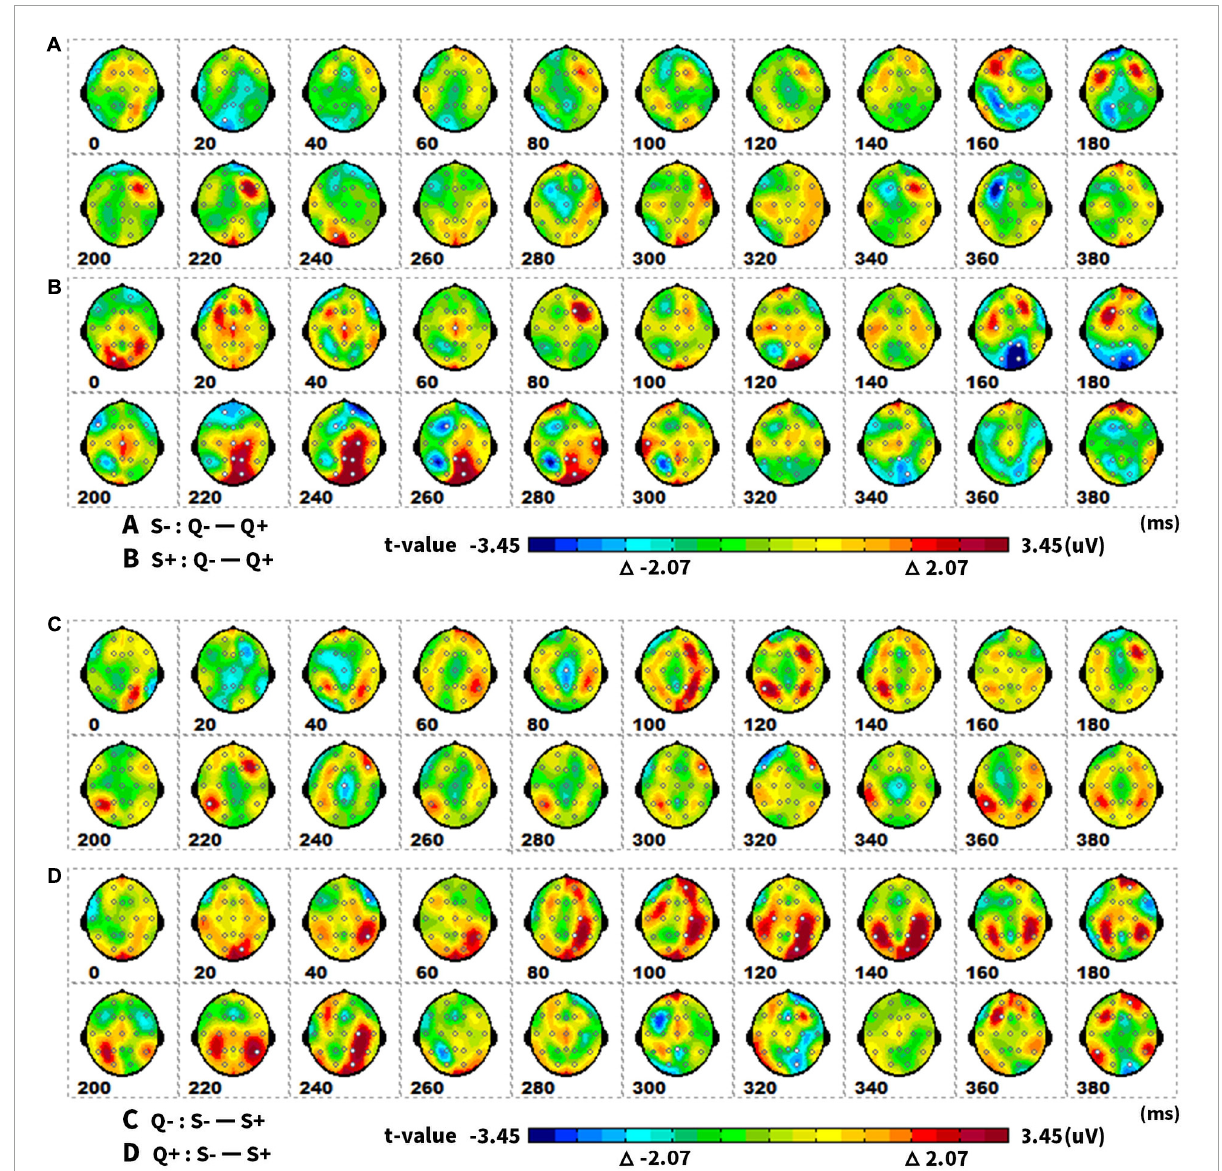
FIGURE7 The spatiotemporal patterns of SPM (t) (0 to 400 ms) are derived from the pairwise comparisons between the conditions (Q–, Q + , S–, S +): (A) (S–. Q– – Q +), (B) (S + . Q– – Q +), (C) (Q–. S– – S +), (D) (Q + . S– – S +). Each map was interpolated from the average t -values within the fixed 20-ms time window, and the red/bright blue bin of the color scale corresponded to the 0.05 significance threshold: t (1,23) = ± 2.07. The white dots represented the electrode sites with significant effects. Q–, singular; Q + , plural; S–, inanimate; S + ,